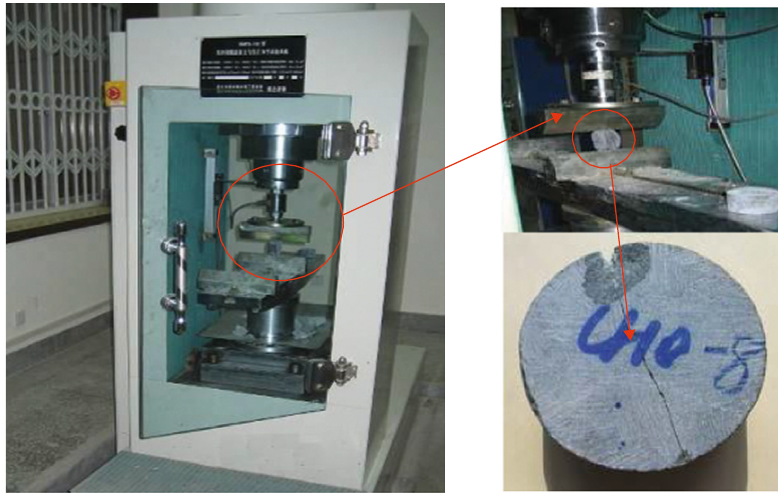
Figure 1: Rock mechanics testing system RMTS150 and specimen.